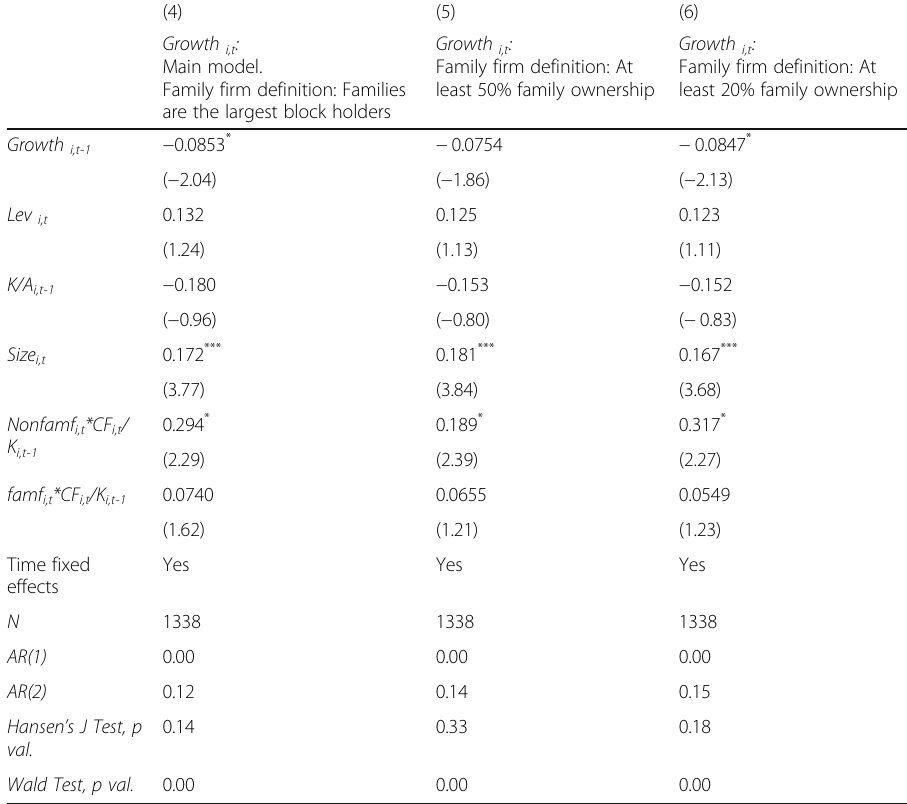
Table 4 GMM Estimation Results